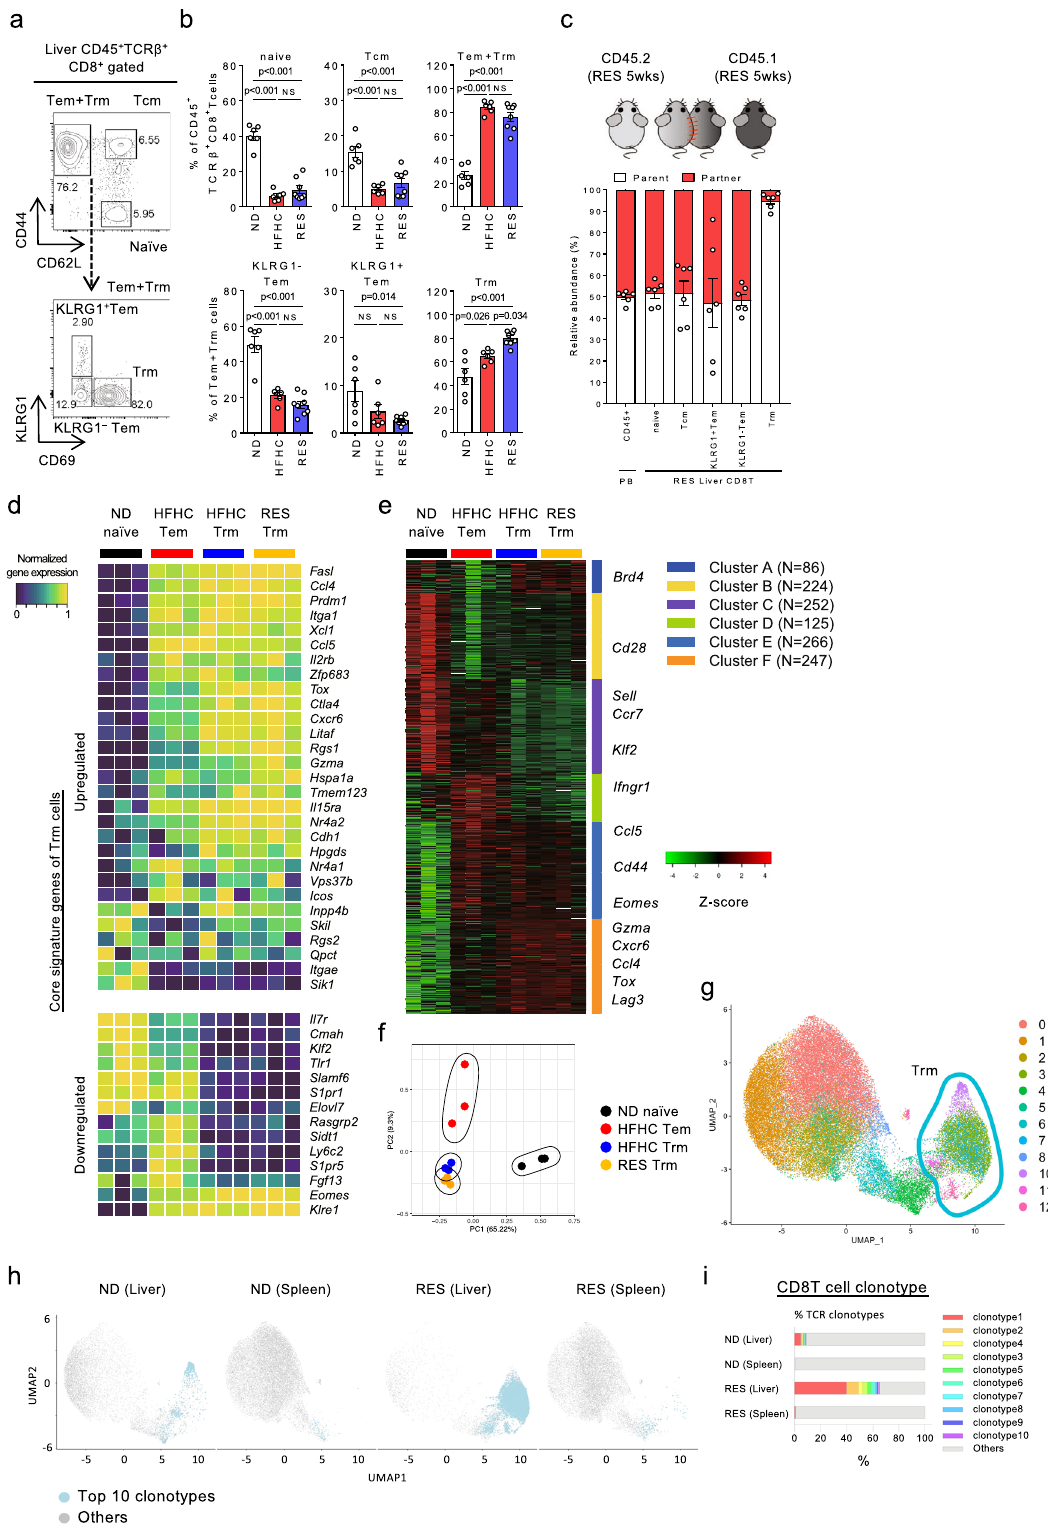
while that between HSCs and HFHC CD8 + Trm was less evident (Fig. 7e), suggesting that the interplay was regulated according to the fi brous niche. To further con fi rm the requirement for CCR5 in fi brosis resolution, we generated HSC-speci fi c CCR5 de fi cient mice by administrating vitamin A-CCR5 siRNA liposomes during the NASH resolution phase (Fig. 7f). We con fi rmed that